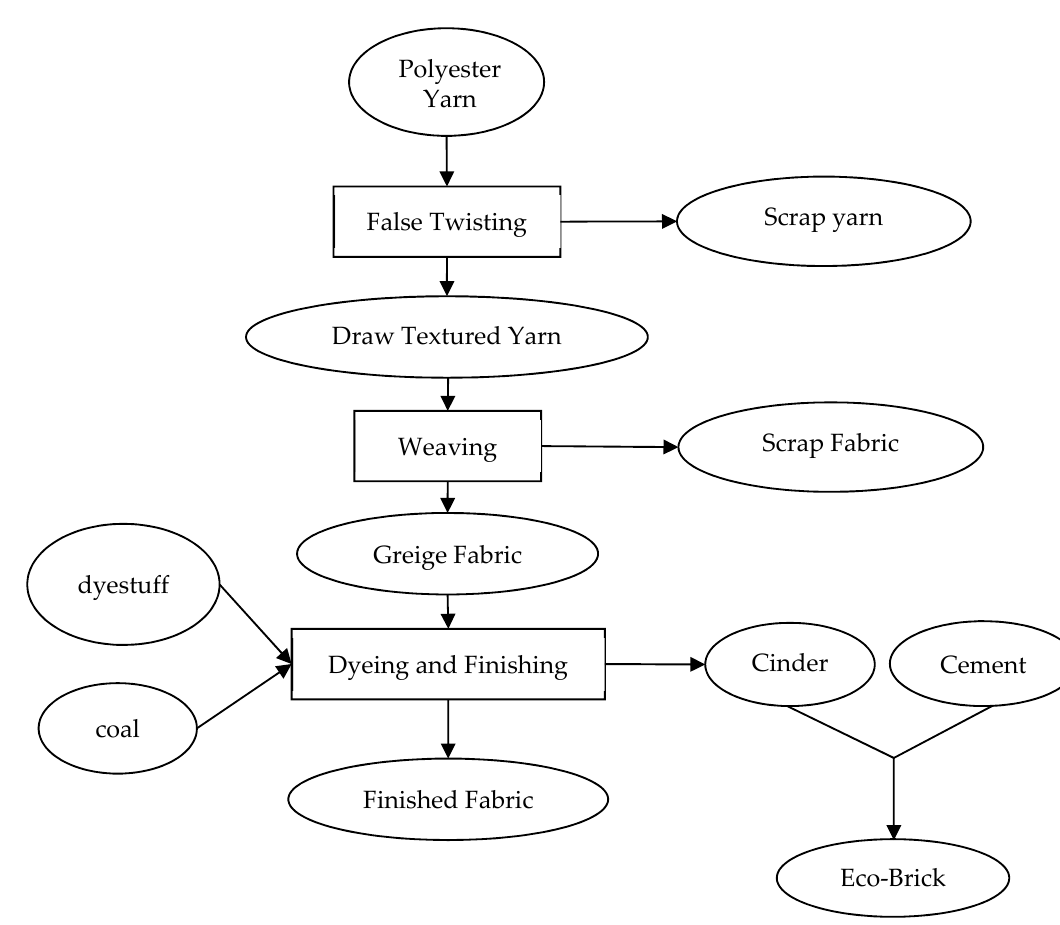
Figure 1. The process of producing textiles